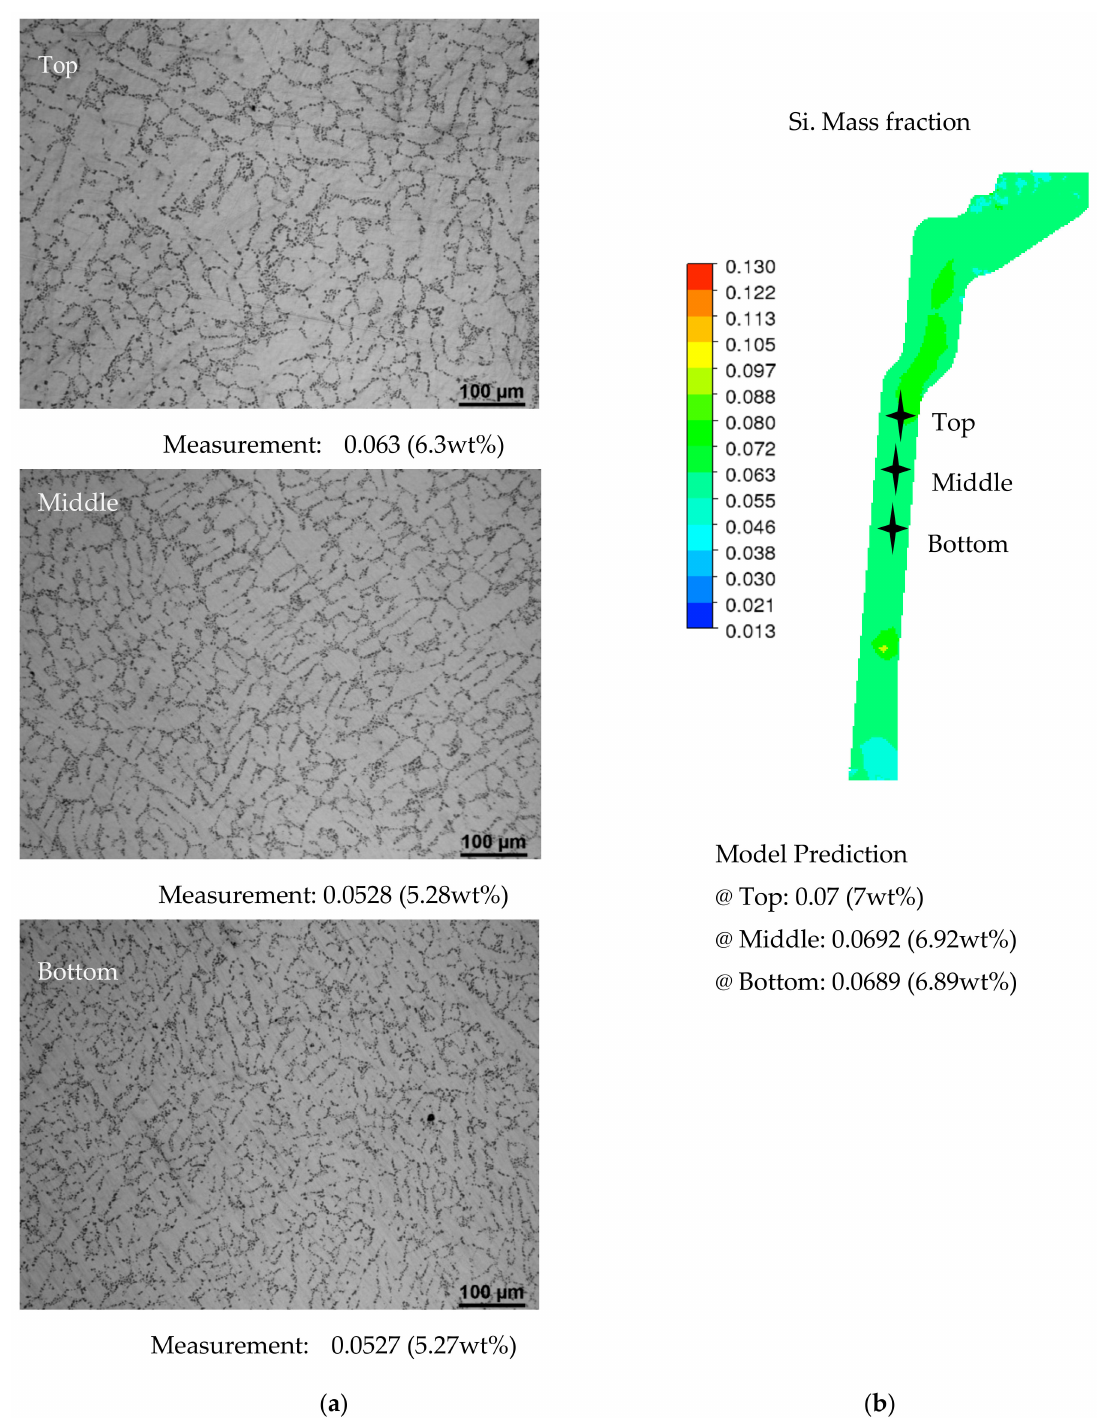
Figure 8. Microstructure in the rim ( a ) and location on wheel where comparisons were made ( b